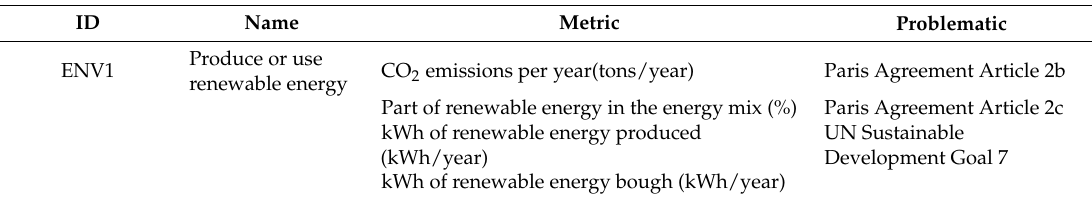
Table 7. Example of metrics to evaluate strategies with the example of ENV